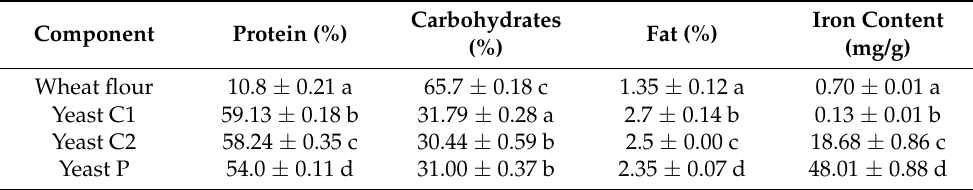
Table 5. Composition of wheat flour and freeze-dried yeast used for the production of flatbread (content given on a dry